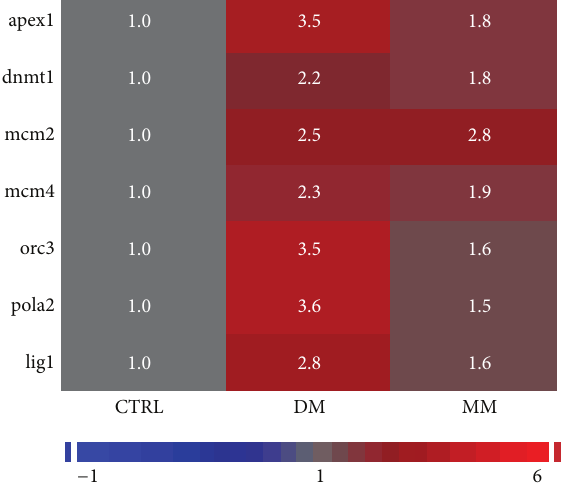
Figure 4: Methylated DNA regions (MRs) of zebrafish gene loci for dnmt1 (a), mcm2 (b), and orc3 (c). Panels (a), (b), and (c) were prepared with IGV genome viewer. The scale on the top shows chromosomal coordinates. This program schematically represents the structure of the gene using conventional elements: (1) blue line represents introns and (2) blue blocks on the line represent exons. Circles with the “TSS” point to the transcription start site and the dashed arrow points in the direction of 5 󸀠 to 3 󸀠 of the DNA strand with the arrow pointing to the MR farthest upstream of the TSS as indicated for each diagram (bp distance indicated in the box above the dashed arrow). Three tracks separated by gray lines below gene track show localization of MRs for each of the three samples to include control (CTRL), diabetic state (DM), and metabolic memory state (MM). Methylated regions detected by the MACS algorithm are shown as red boxes. Those upstream of the TSS that are lost in both the DM and MM states are numbered (MR1, MR2, etc.) and shown within circles over the red bars. The sequence counts for MACS peaks are shown under each MR. (a) dnmt1 , (b) mcm2 , and (c) orc3 . (a) dnmt1 , chromosomal coordinates